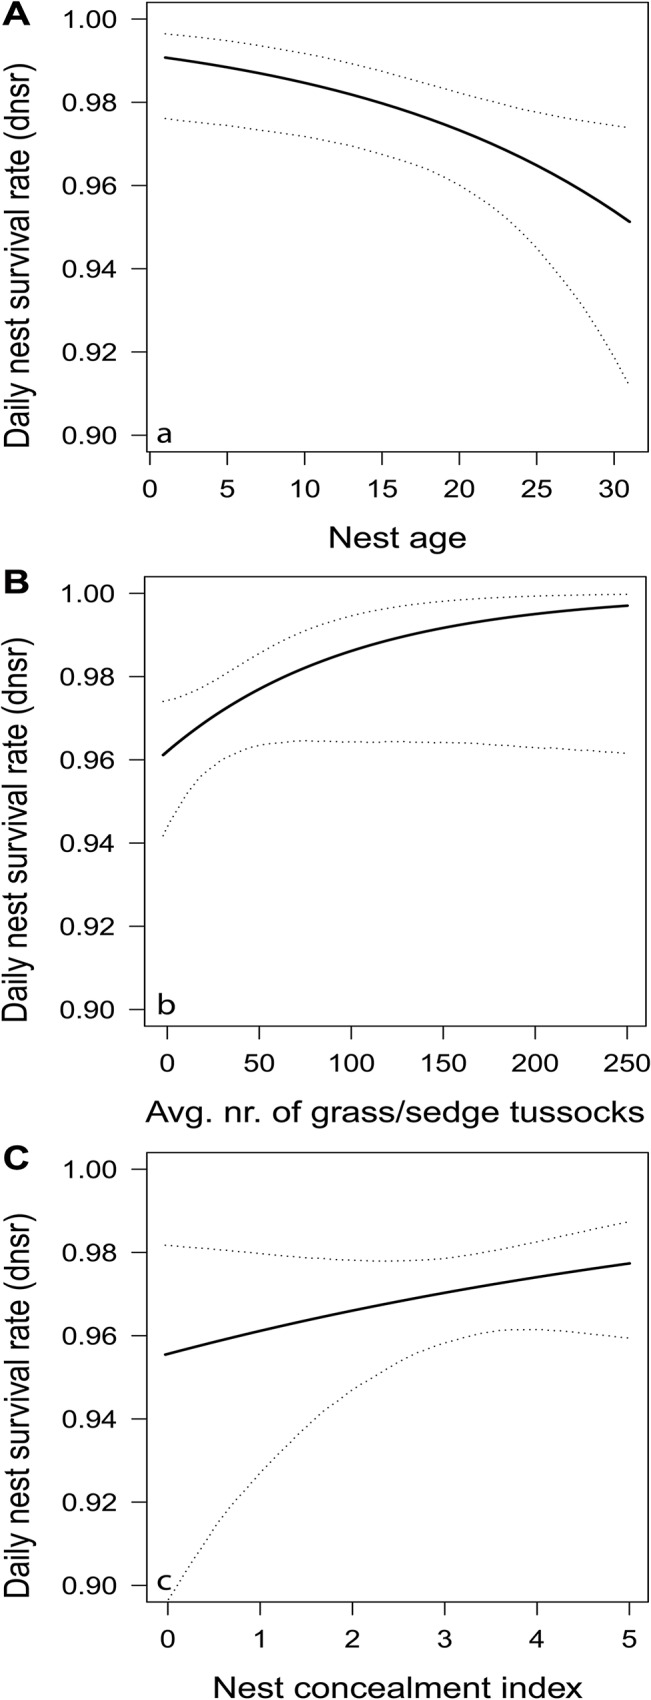
Daily nest survival rate in relation to a) nest age (in days), b) number of grass and sedge tussocks in a given territory, and c) nest concealment.Plots show fitted values (solid lines) and 95% confidence intervals (dashed lines) based on a model that includes nest age, number of grass and sedge tussocks and nest concealment (Table 3, AHA results, n = 115).